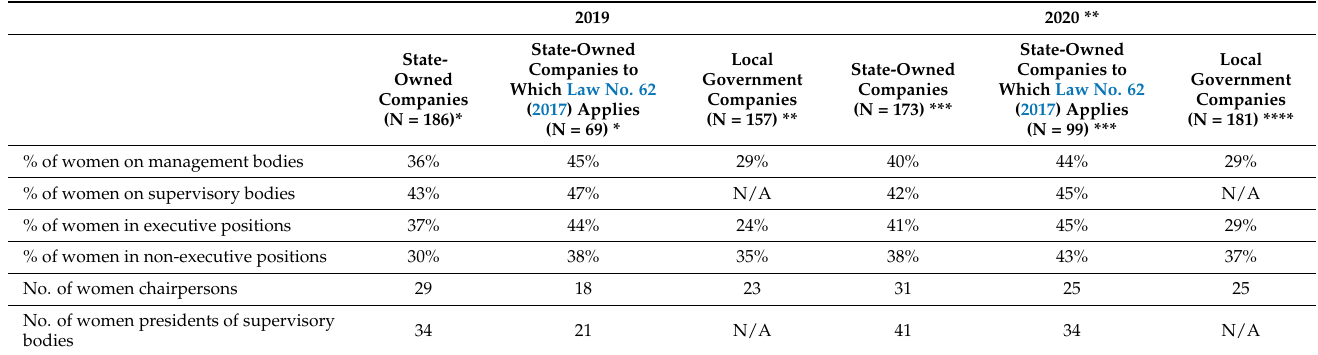
Table A2. Representation of women on the management and supervisory bodies of state-owned and local government companies in Portugal